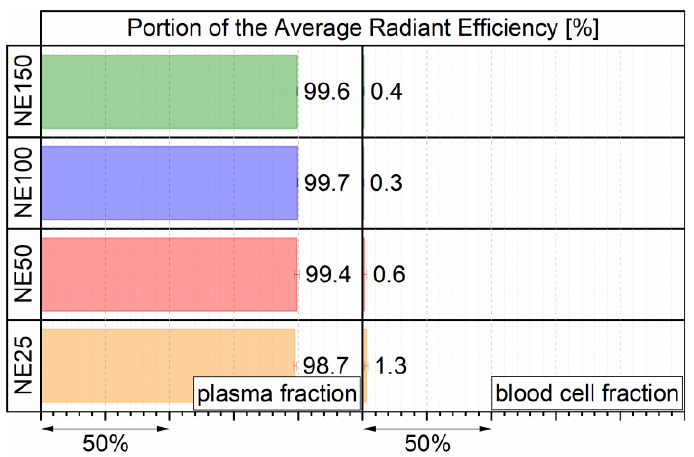
Figure 4. PARE in plasma and blood cell fractions after 4 h of incubation, determined by three indi- vidual incubated